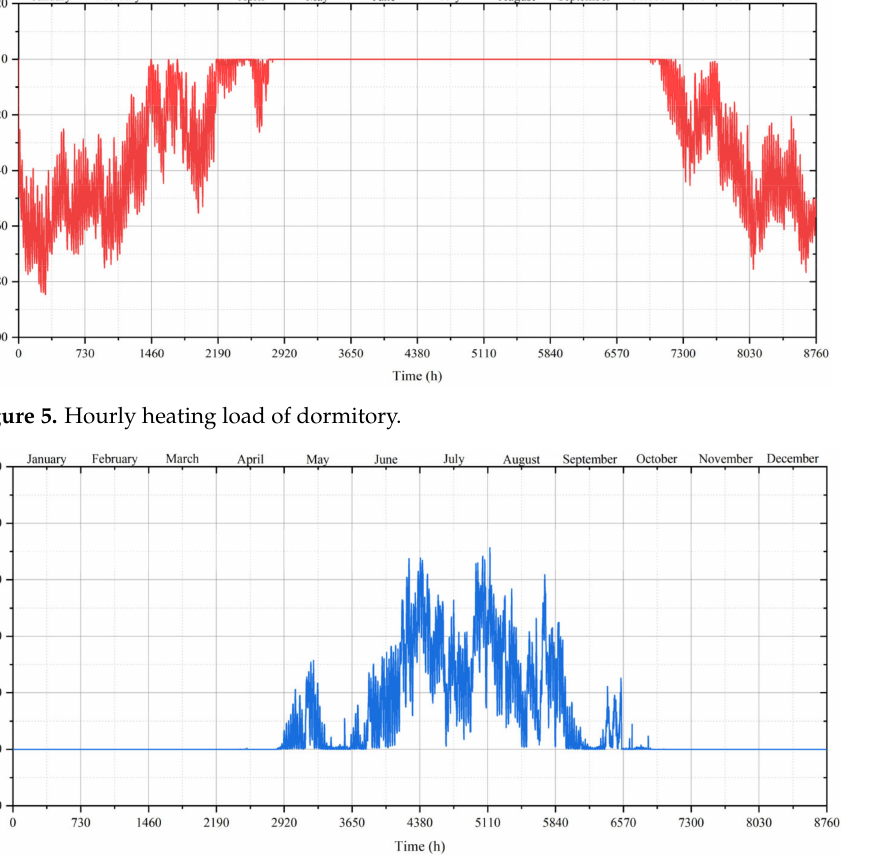
Figure 6. Hourly cooling load of